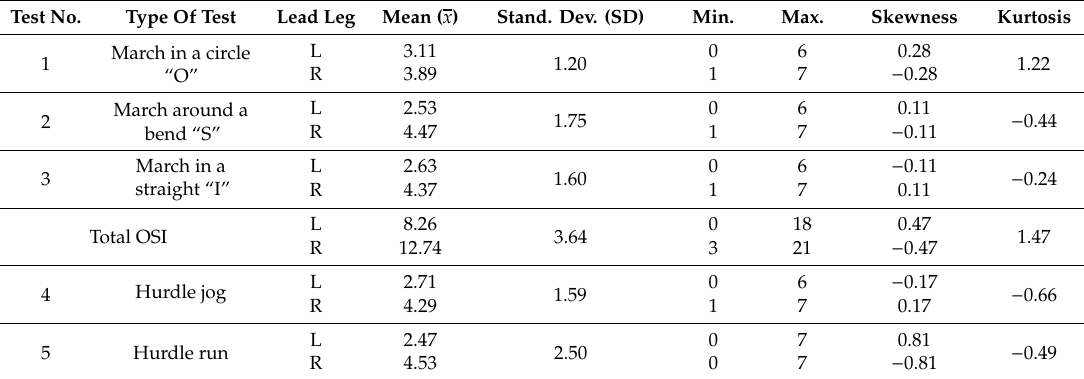
Table 2. Lead-leg functional asymmetry in tests involving hurdle clearance at a marching pace (data in %) and the results of tests performed in a jog and a